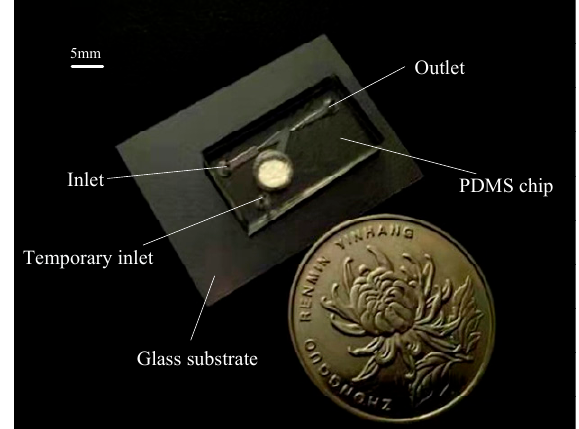
Figure 6. Photograph of one thermal bubble-driven micropump.